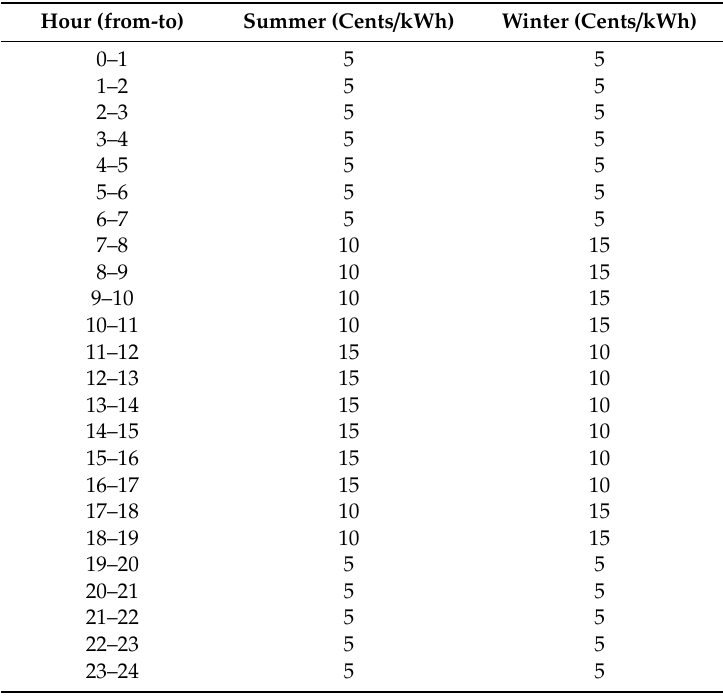
Table 2. Hourly pricing for summer and